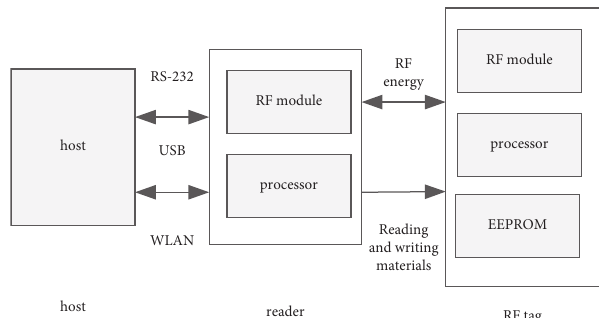
Figure 6: Working principle of RFID